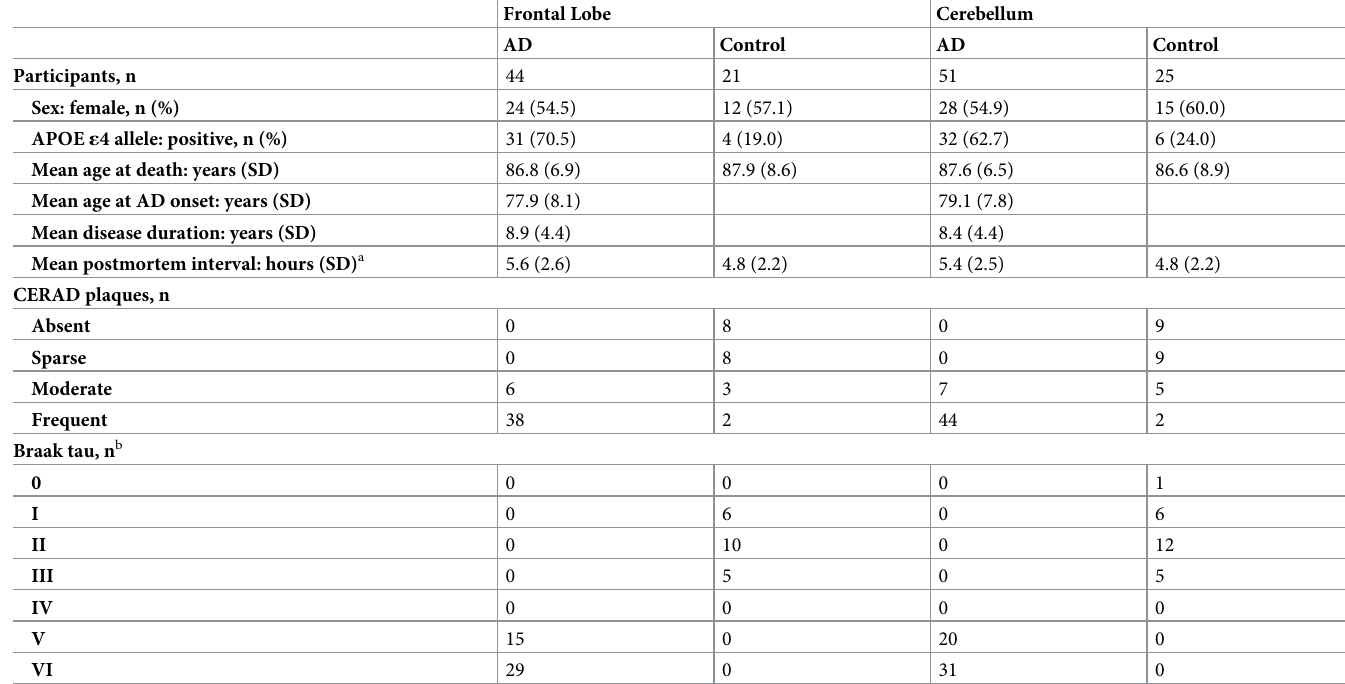
Table 1. Demographics of the study